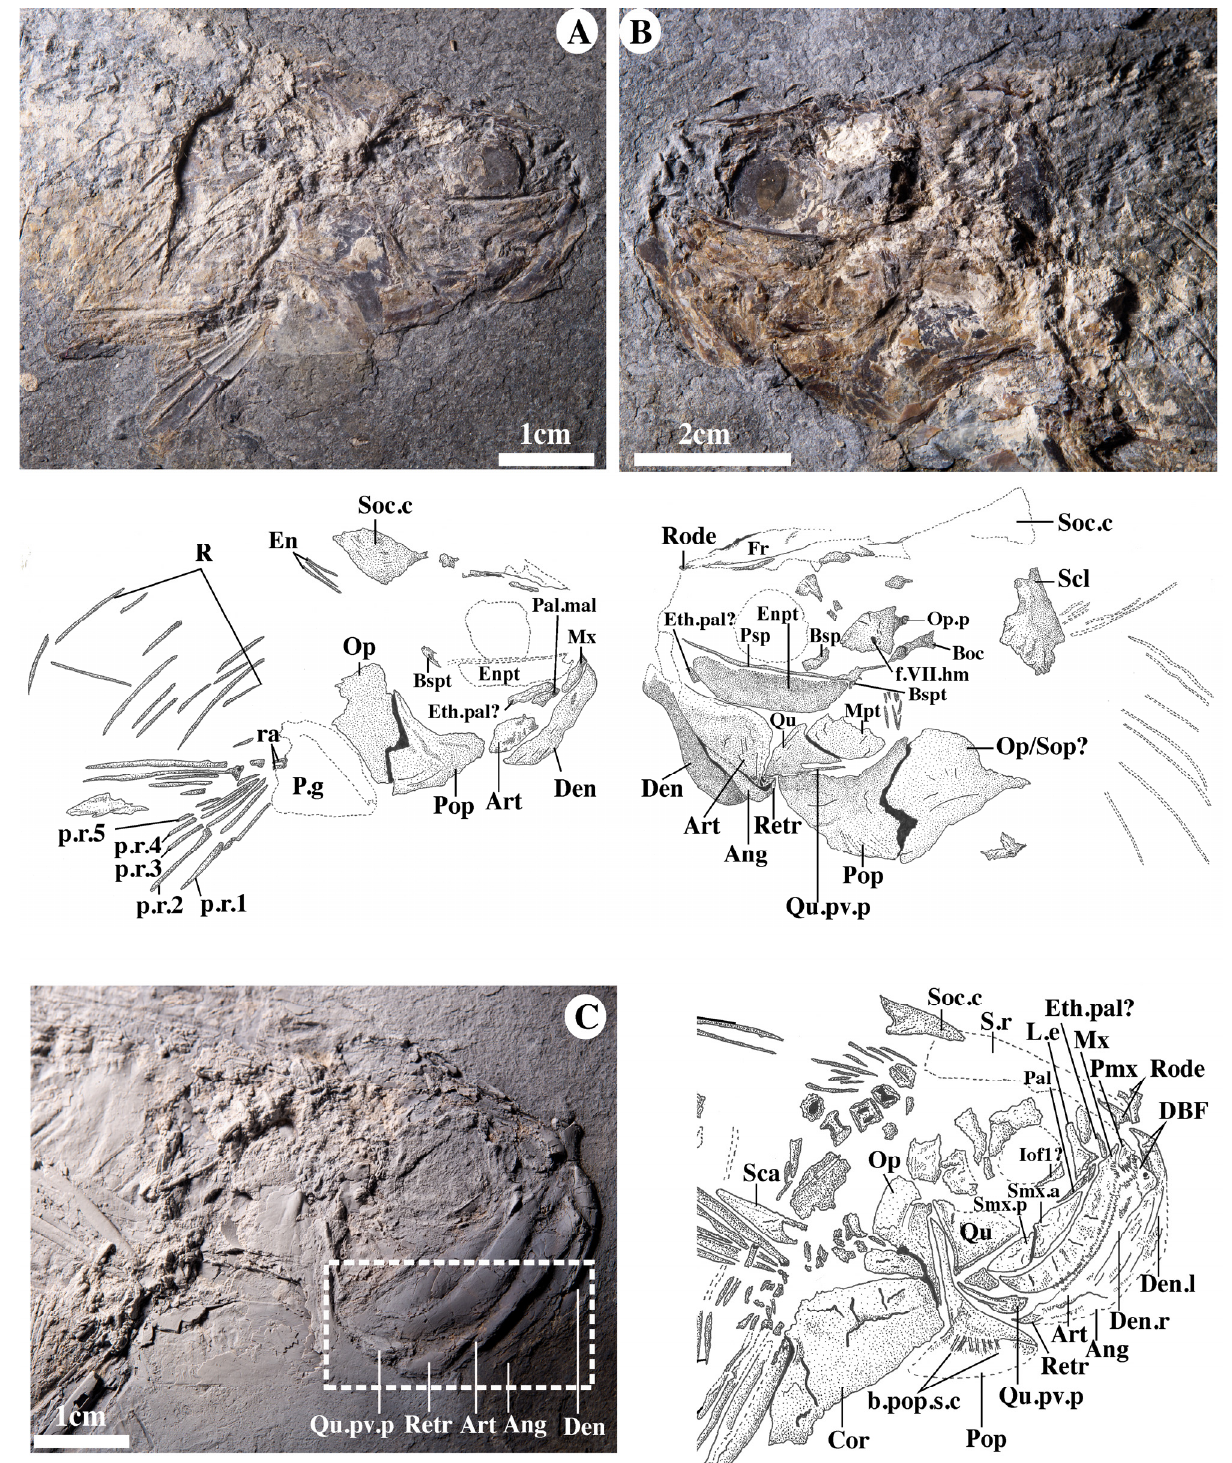
Figure 6. Photo and interpretative of head details of the holotype and paratype of † Cladocynodon araripensis gen. et sp. nov. ( A ) photo and interpretative draw of the exemplar CFUFMT 432A (part). ( B ) Photo and interpretative draw of the exemplar CFUFMT 432B (counterpart). ( C ) photo with a demarcated area (to enhance the contrast in this specific region, the specimen was treated with ribbon magnesium, which made it possible to detail the specific bone pieces related to the quadrate facet) and interpretative drawing of the holotype CFUFMT 139, highlighting the mandibular joint.